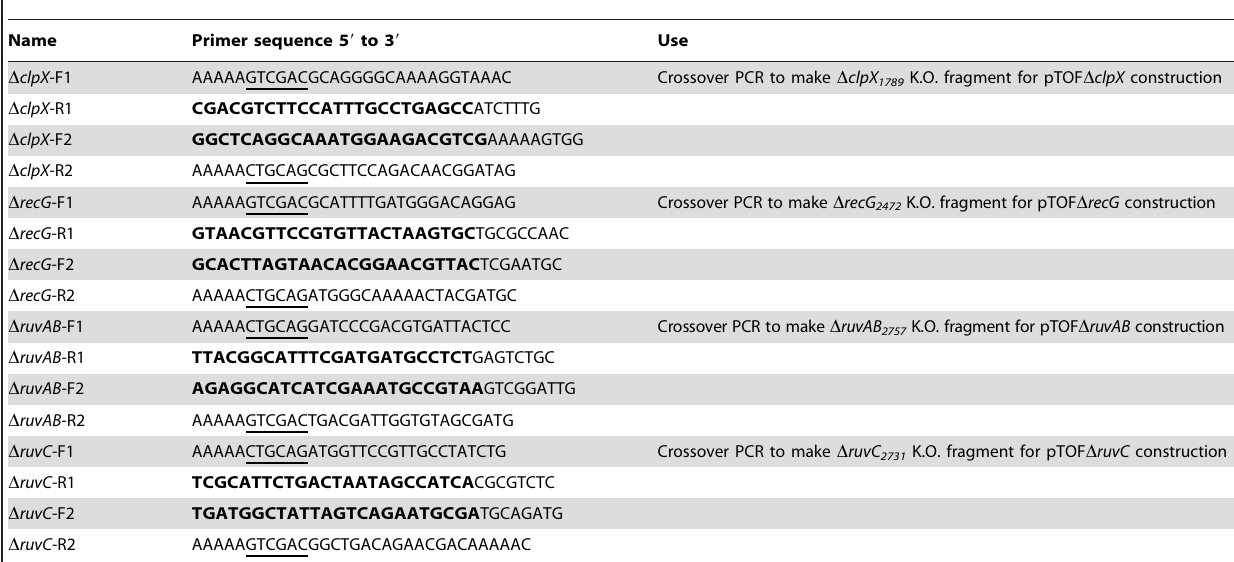
Table 2. Restriction enzyme sites are underlined and the complementary parts of the primers useful for the crossover strategy are shown in